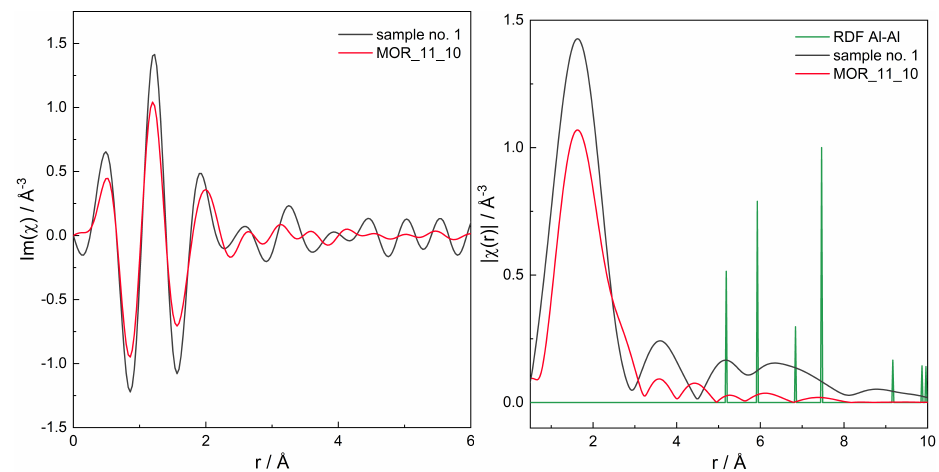
Figure 8. Spectrum of µ ( E ) ( upper left panel ), k 2 χ ( k ) ( upper right ), (cid:61) χ ( r ) ( lower left ), and | χ ( r ) | ( lower right ) for sample no. 1 (MOR of Si/Al = 15) and simulation for computational model labelled MOR_11_10. Matching RMS = 0.1445. The simulation model characterised by Al–Al distances of: 5.2, 6.0, 7.5, and 9.9 Å.